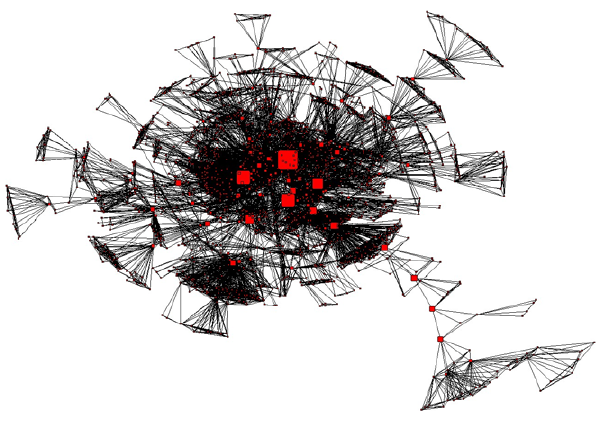
Figure 2. Major component of the co-authorship network of Brazilia scientists publishing on tuberculosis, 1995–2010. Node size proportional to the calculated betweenness centrality measure of authors (Table